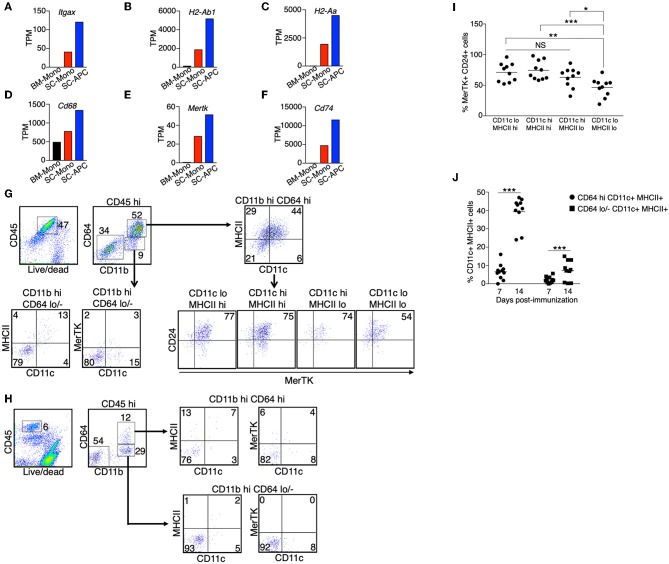
Monocyte-derived APCs expressed gene signatures for both dendritic cells and macrophages. (A–F) The gene expression level of Itgax
(A), H2-Ab1
(B), H2-Aa
(C), Cd68 (D), Mertk (E), and Cd74 (F) in monocytes isolated from the bone marrow (BM-Mono) or spinal cords (SC-Mono), and the monocyte-derived APCs isolated from the spinal cords (SC-APC) at days 14–15 following EAE induction. Shown are TPM values from RNA-Seq analysis. (G–J) Spinal cord cells were isolated at days 14–15 (G) or day 7 (H) following EAE induction. The expression of surface markers for dendritic cells (CD11c, MHC II) and macrophages (MerTK, CD24) in the CD45hi CD11bhi CD64+ Ly6G− cells or the CD45hi CD11bhi CD64− Ly6G− cells was determined. Shown are representative plots from three independent experiments, with a total of 10–11 animals in each time point. (I) Percentage of cells expressing MerTK and CD24 within the CD11c/MHCII subpopulations from individual animals is shown. (J) Percentage of cells expressing CD11c and MHCII within the CD64hi or CD64lo/− populations from individual animals is shown. *P < 0.05; **P < 0.01; ***P < 0.001. NS, not statistically different.